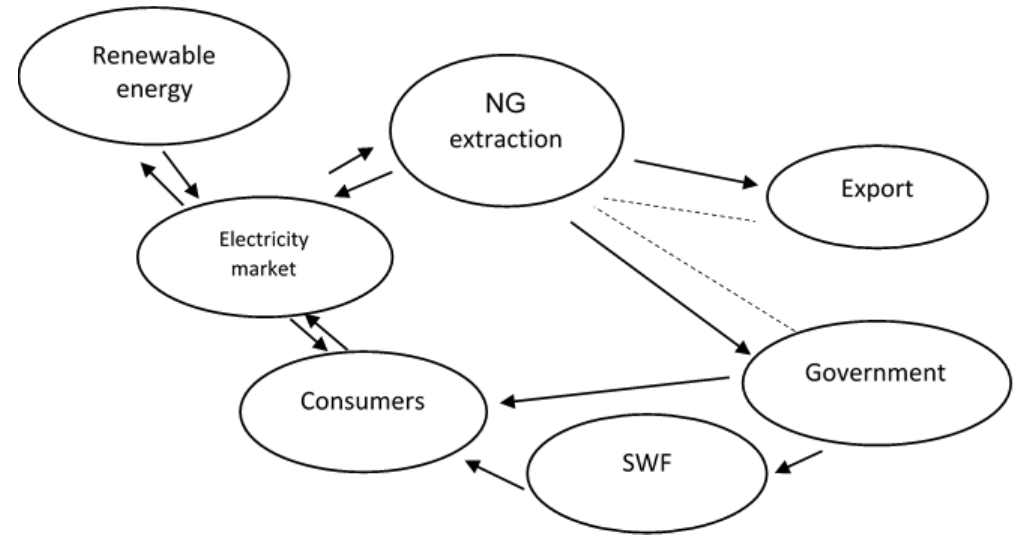
Figure 1. Diagram of the modeled economy.